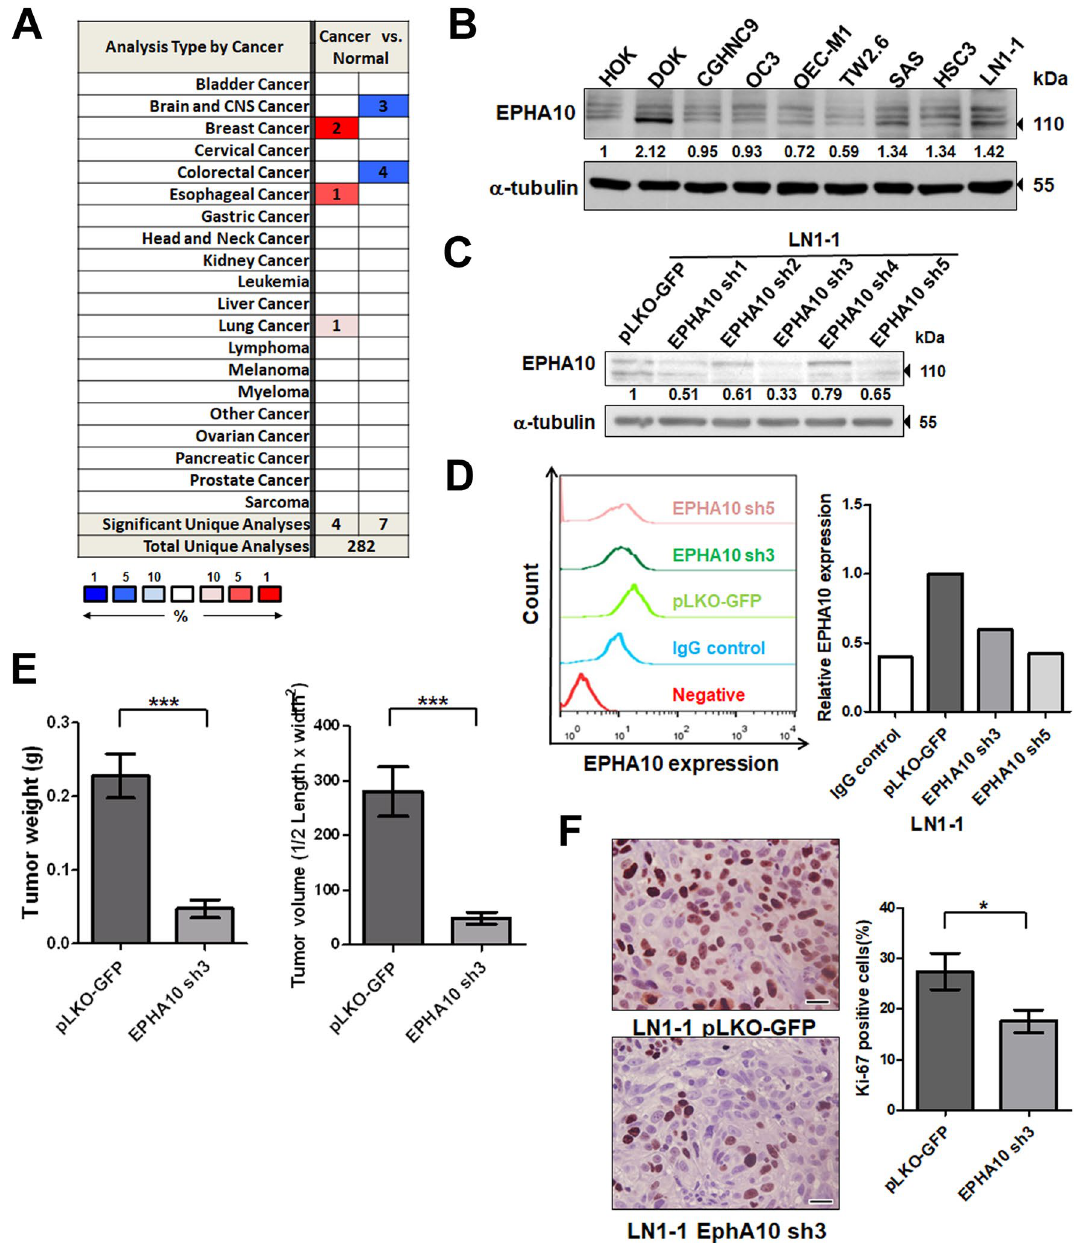
Figure 1. EPHA10 is required for tumorigenesis and metastasis of OSCC cells. ( A ) Expression of EPHA10 in 20 types of cancer versus corresponding normal tissues using the Oncomine database with the threshold of fold change ≥ 2, p ≤ 10 –4 , and gene rank ≥ top 10%. Red and blue, respectively, indicate the numbers of datasets with statistically significant increases and decreases in EPHA10 gene expression. ( B ) EPHA10 expression in human oral keratinocytes (HOK), immortalized dysplastic oral keratinocytes (DOK), and 7 OSCC cell lines was examined by western blotting. Protein levels were normalized to an internal control (α-tubulin). Relative ratios were determined by dividing the EPHA10 protein level in each cell type by that in HOK cells. ( C ) EPHA10 protein levels in LN1-1 cells expressing EPHA10-specific shRNA and vector control (pLKO-GFP) were determined by western blot. Protein levels were normalized to α-tubulin. Relative ratios were determined by dividing the EPHA10 protein level in each expression variant by that in the pLKO-GFP vector-expressing cells. ( D ) EPHA10 protein levels in LN1-1 cells expressing pLKO-GFP (green line), sh3 (dark green line), and sh5 (pink line) were determined by fluorescence activated cell sorting (FACS). Relative EPHA10 expression was determined by dividing the fluorescent intensity in each expression variant by that in the pLKO-GFP vector- expressing cells. ( E ) Tumor weights and volumes in mice orthotopically injected with LN1-1 pLKO-GFP (n = 9) or EPHA10 sh3 cells (n = 8). ( F ) Ki-67 expression by immunohistochemistry (IHC) in LN1-1 pLKO-GFP (n = 9) and EPHA10 sh3 tumors (n = 7). Left: Representative fields of IHC stained sections. Scale bars, 20 μm. Right: The percentages of Ki-67-positive cells per field were calculated for each group. Error bars represent SE; * p < 0.05; *** p <